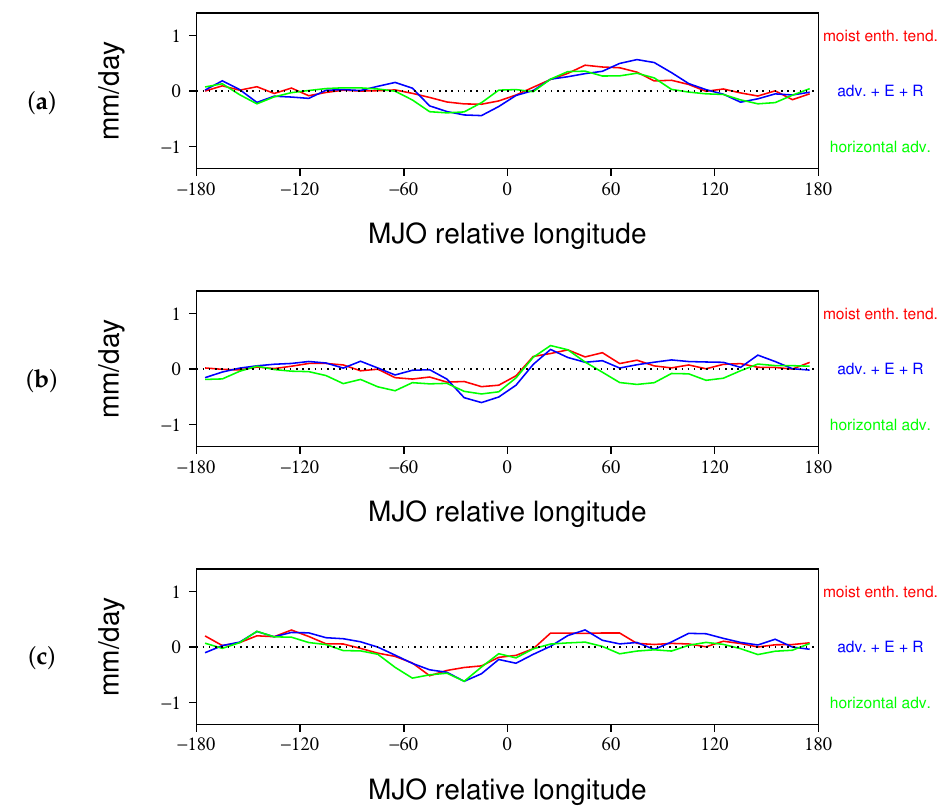
Figure 7. Comparison of moist enthalpy tendency (red line) with the sum of all the terms that contribute to it (blue line). Due to the facts that advective tendencies are sampled on a 1-day interval and that the effects melting and freezing are neglected, small random deviations between the red and blue curves are expected. Horizontal advection of moist enthalpy (green line) accounts for most of the change in moist enthalpy. Panels ( a – c ) are for the developing, mature, and dissipating stages of the MJO